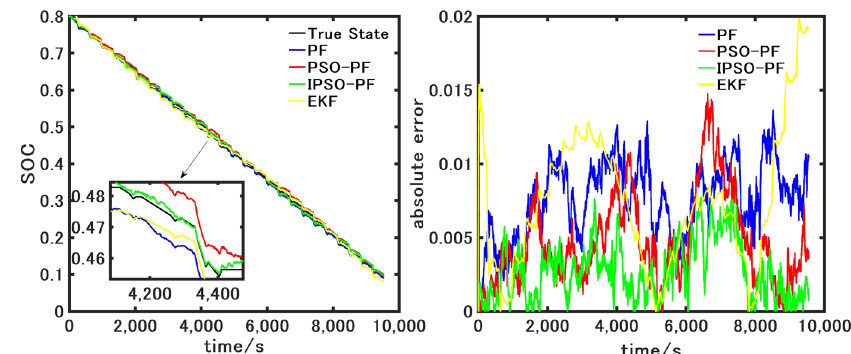
Figure 16. Weight Distribution at SOC = 0.2.